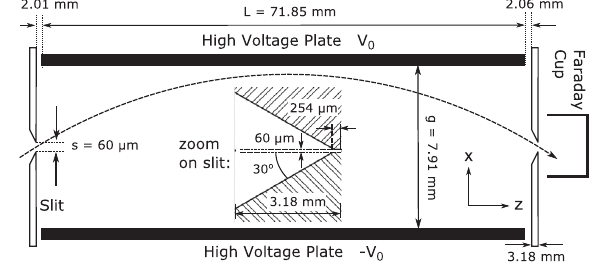
FIG. 1. Side-view of the FRIB Allison